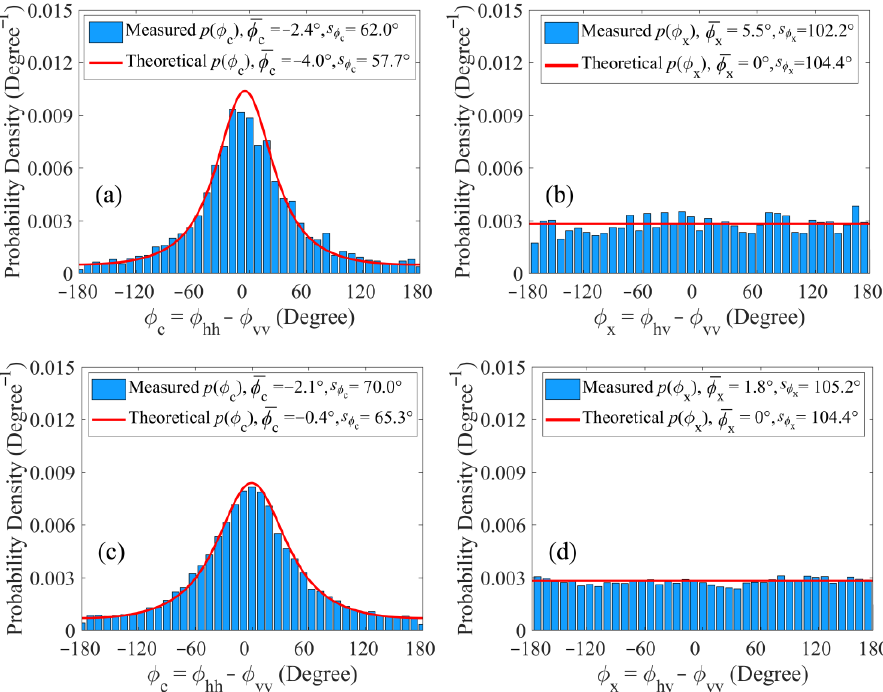
Figure 11. Measured and theoretical phase differences of the backscatter from rice field Scene 2 at the Ku band and an incidence angle of 10°. ( a , b ) represent the CPD and XPD of SAR data, respectively, and ( c , d ) denote the CPD and XPD of the scatterometric data, respectively.